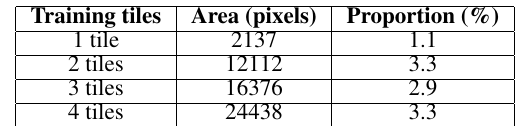
Table 2. Deforestation area in the training